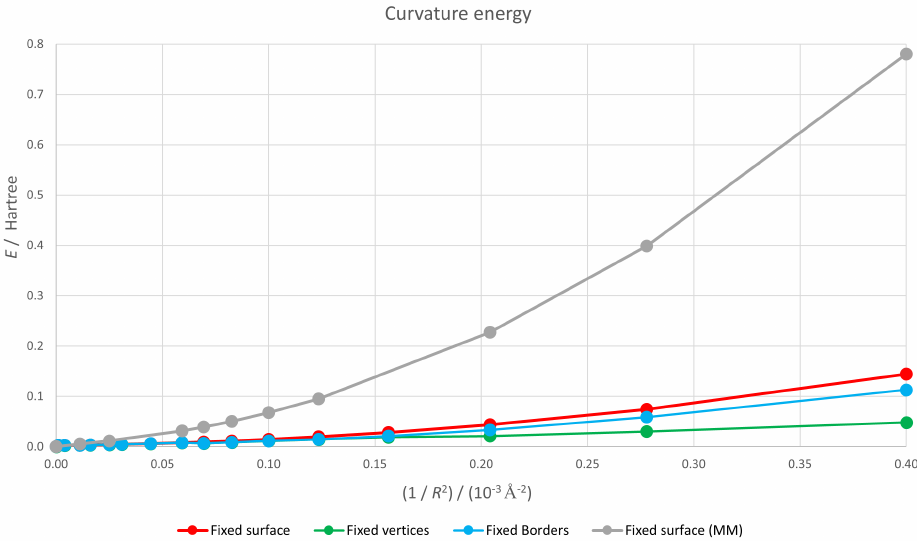
Figure 3. Energy of a (quasi-)spherical graphene flake as a function of its curvature. Flat configuration is taken as energy origin. Lines are merely guides for the eye.